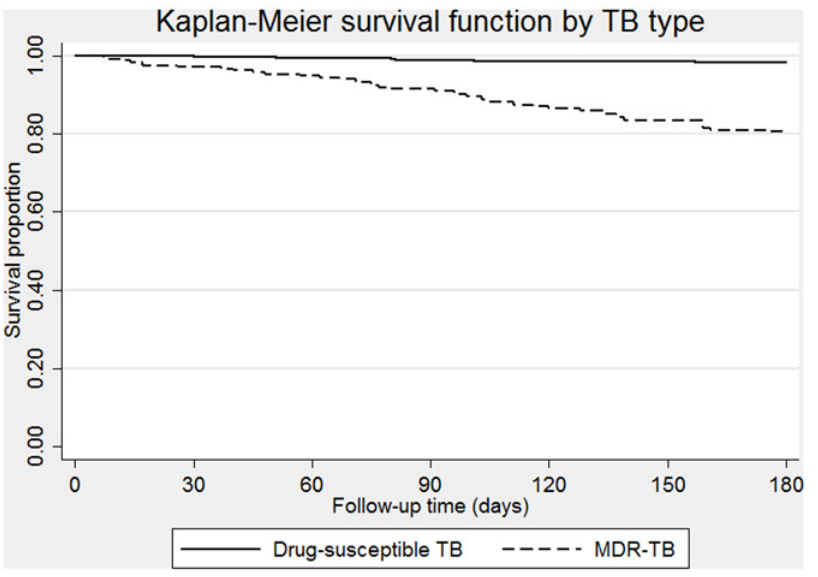
Fig 1. MDR-TB survival curves using Kaplan-Meier